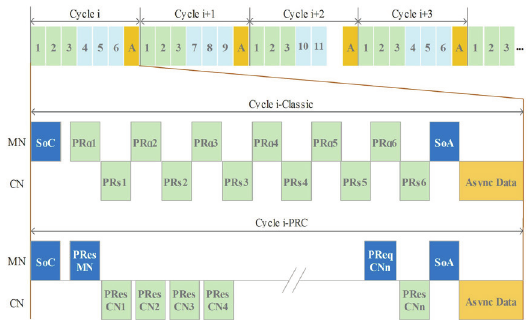
Fig. 2. TDMA Mechanism at EPL Data Link Layer.